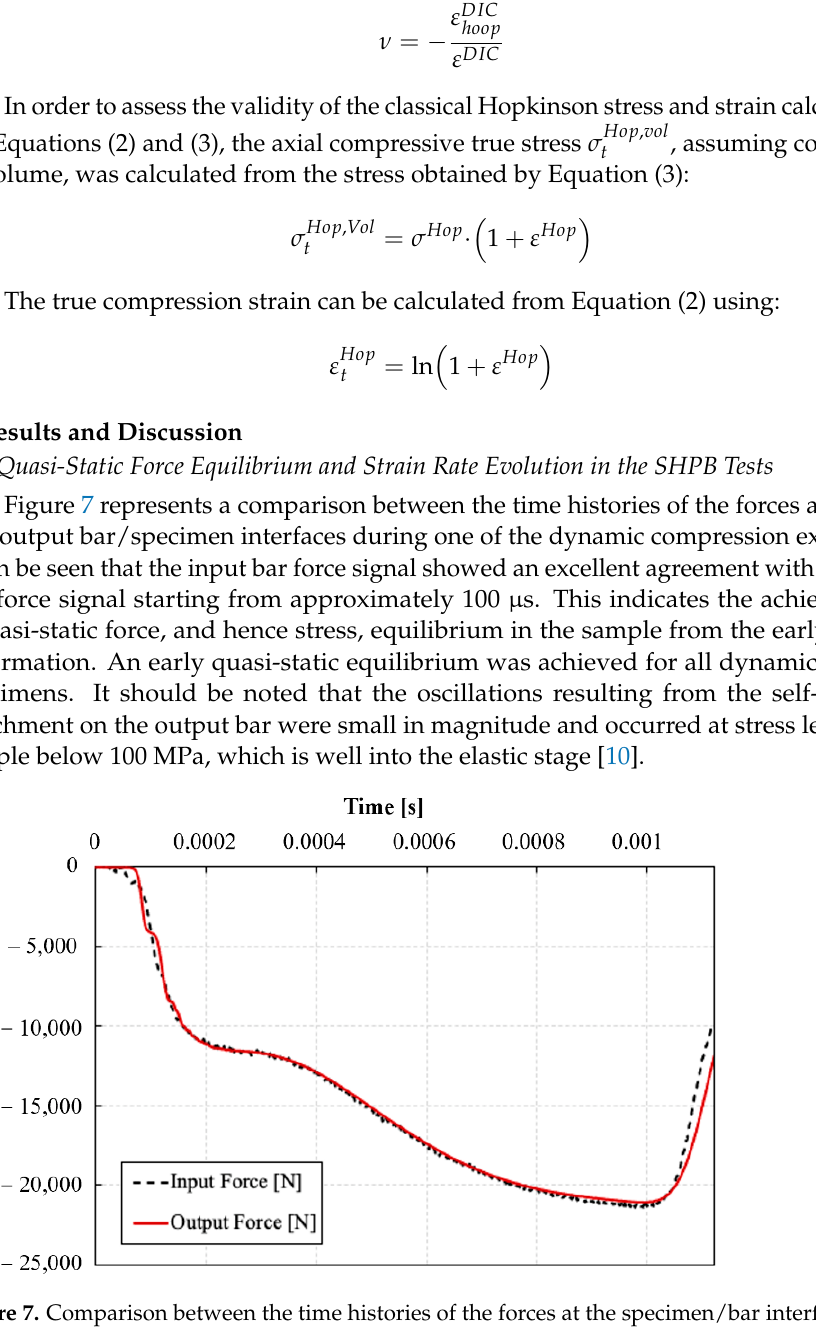
Figure 7. Comparison between the time histories of the forces at the specimen/bar interfaces during an SHPB test.